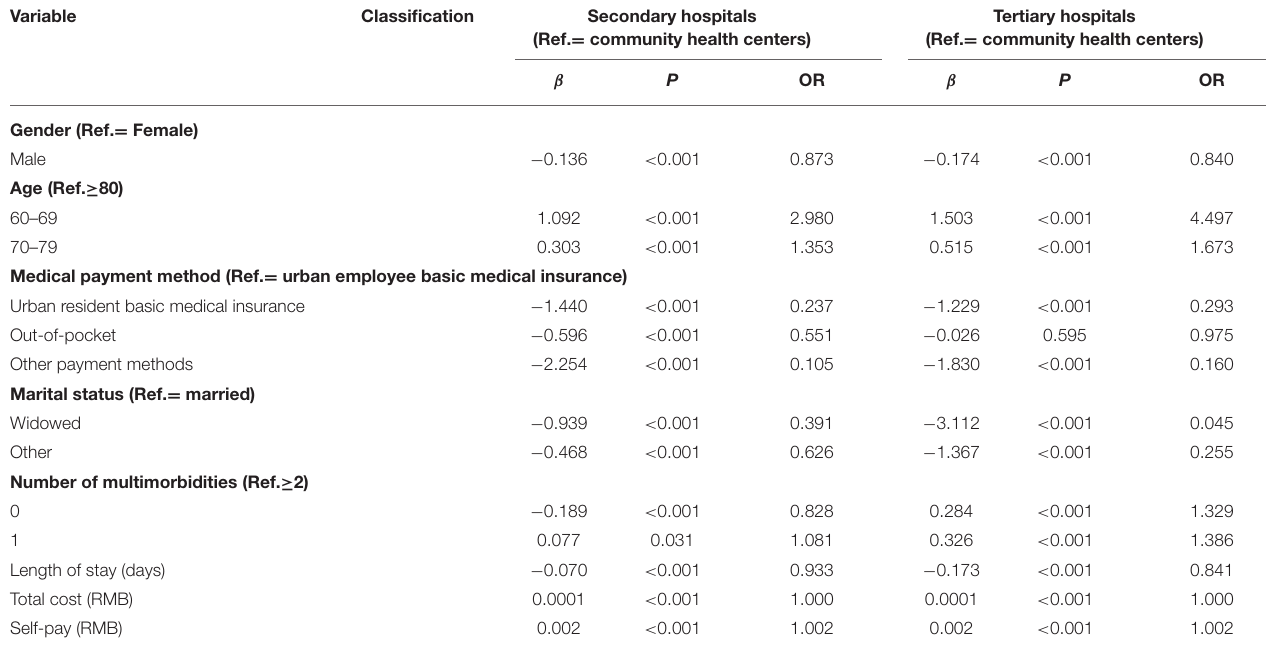
TABLE 2 | Multinomial logistic regression analysis of aged inpatients’ choice during 2013–2016 ( n = 95,445).